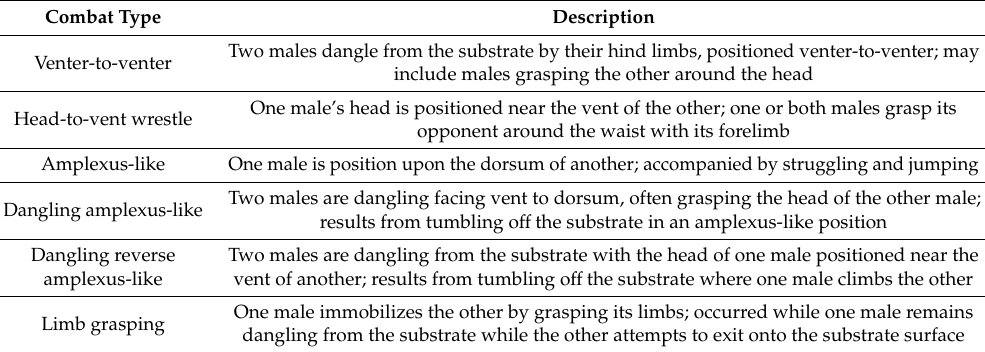
Table 6. Description of combat types observed for Nymphargus grandisonae [51].